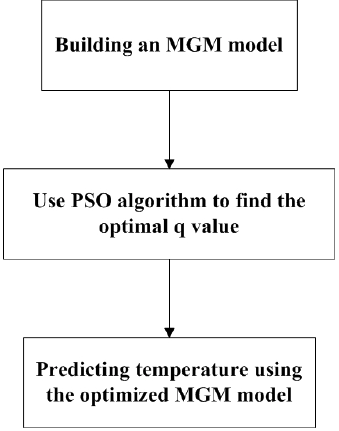
Figure 1. The steps of the PSO algorithms.